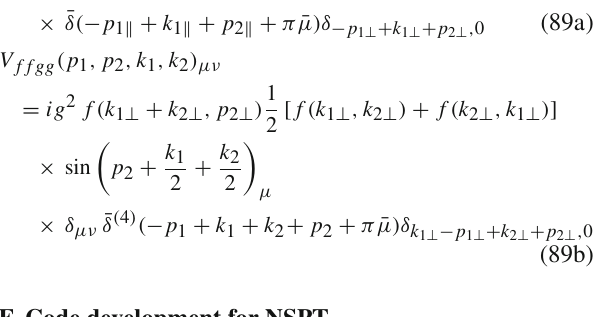
ical links twisted according to the matrix (cid:14) 1 . In the right panel both ˆ 1 and ˆ 2 are twisted directions: in blue there are auxiliary sites whose links are twisted according to the matrix (cid:14) 2 . In the latter case there are sites which pass the boundary in two twisted directions: the green links undergo both the (cid:14) 1 and the (cid:14) 2 twist (the two operations commute by